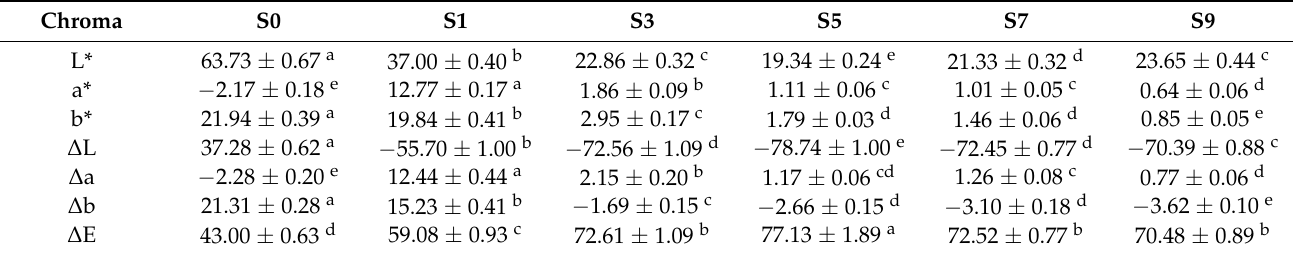
Table 2. Chromaticity of samples with different fermentation